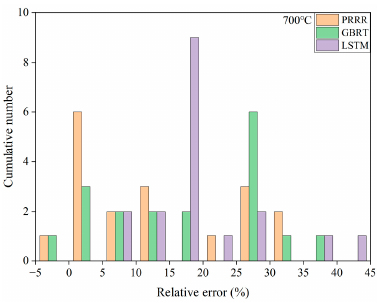
Figure 6. Relative errors of the predicted results to the experimental data for the different machine learning models in Figure 5. The range of relative errors is the same between the same numbers on the horizontal axis.